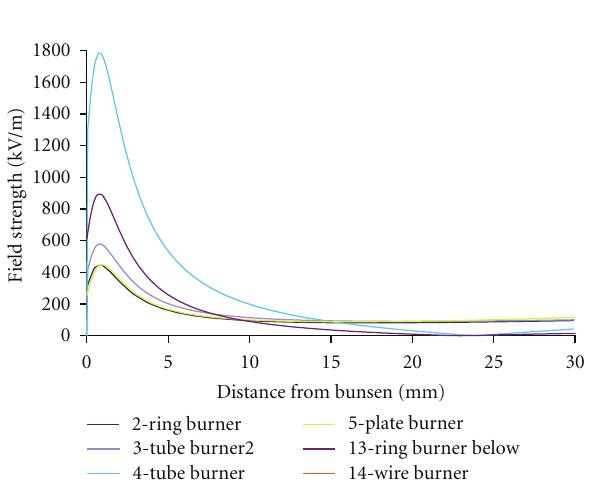
Figure 11: A ff ect of variations to the upper electrode.